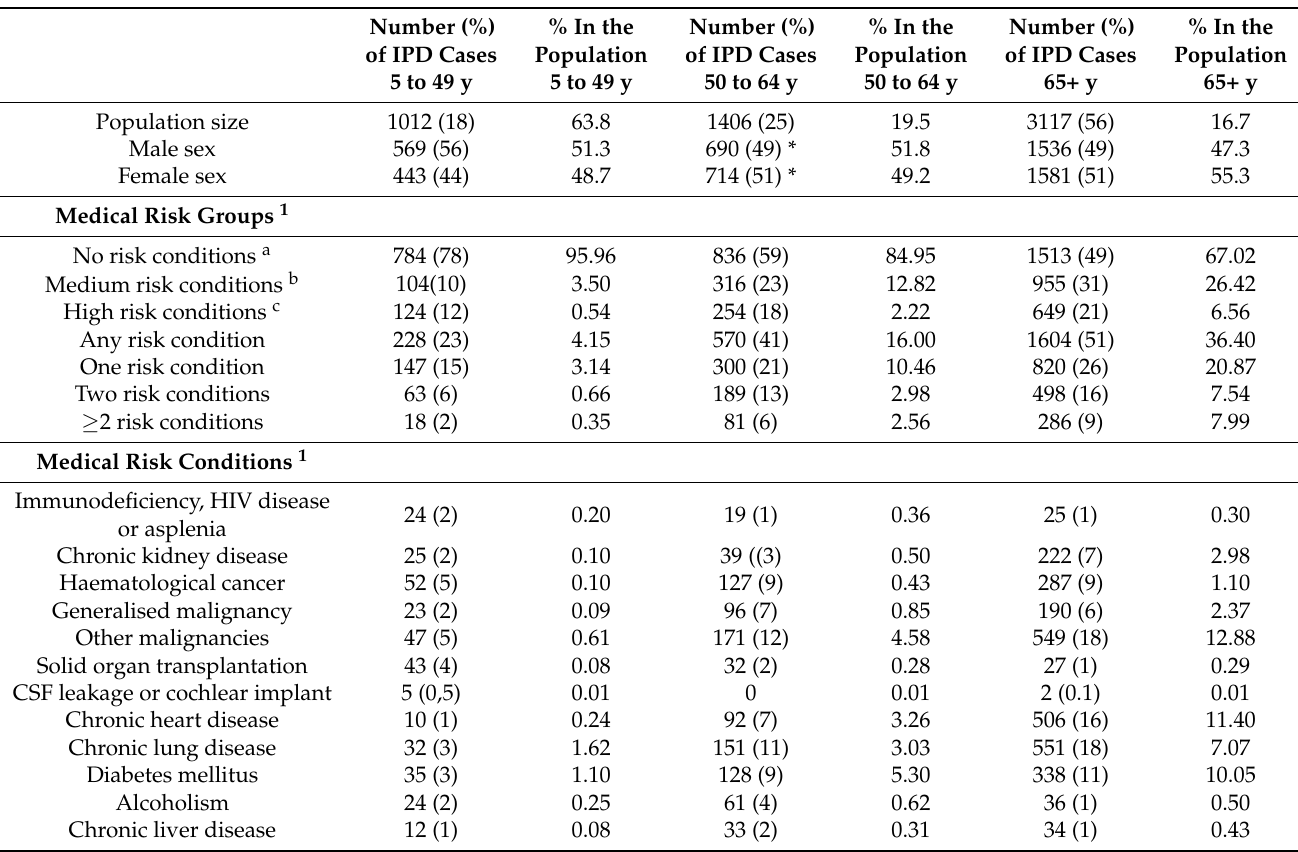
Table 1. Characteristics of the study population. Number (%) of medical risk conditions 1 in IPD cases and (%) in the Norwegian population aged 5 years or older, by age group,